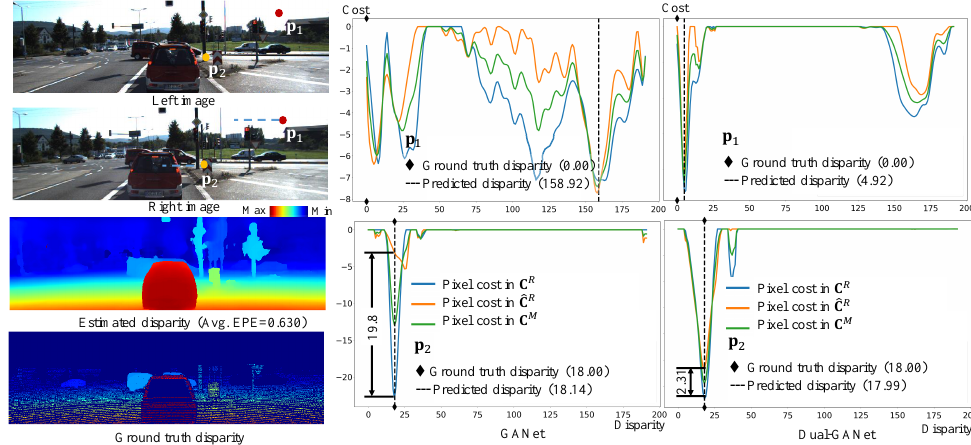
Figure 9. Comparison of the disparity probability distributions of pixels in the cost volumes of the GANet ( left ) and Dual-GANet ( right